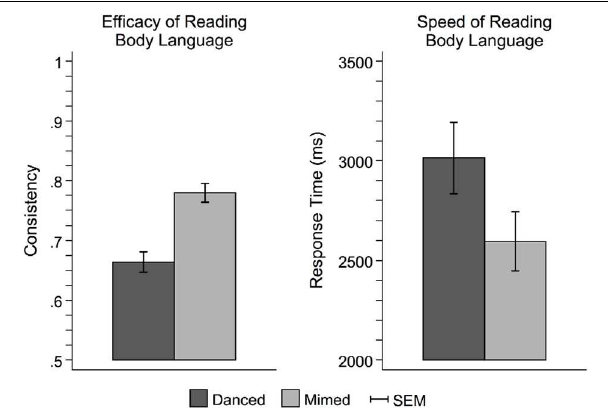
clusters active during movement observation, as labeled in Figure 4 . Region names were obtained from the Harvard-Oxford Cortical and Subcortical Structural Atlases (Frazier et al., 2005; Desikan et al., 2006; Makris et al., 2006; Goldstein et al., 2007; Harvard Center for Morphometric Analysis;